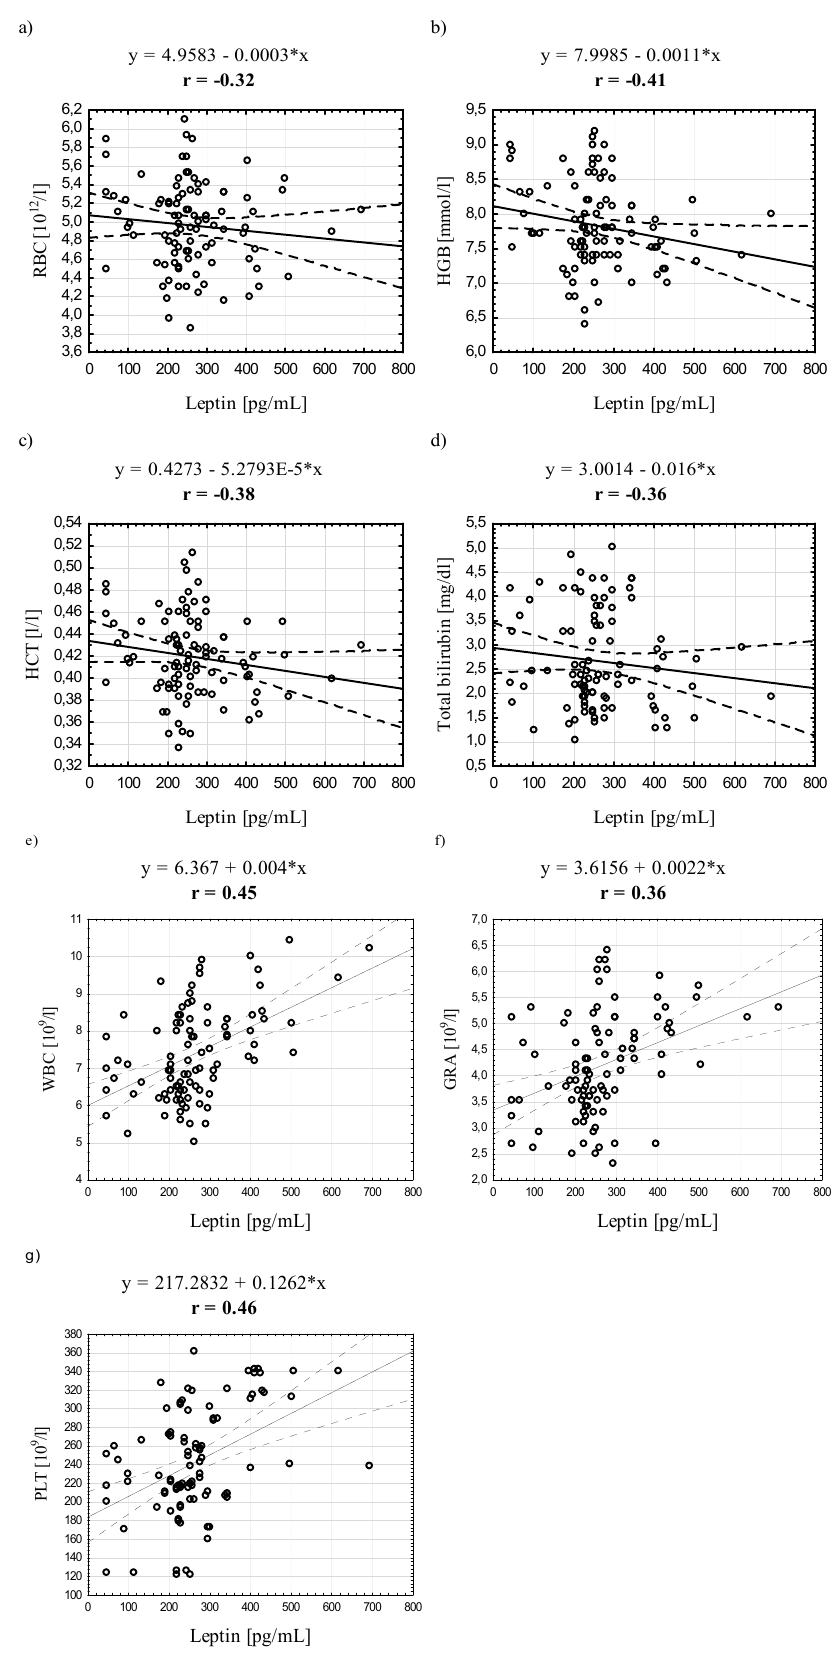
Figure 3. Scatter plots for the correlation ( p < 0.05) between leptin and selected red and white blood cell indicators in the entire study